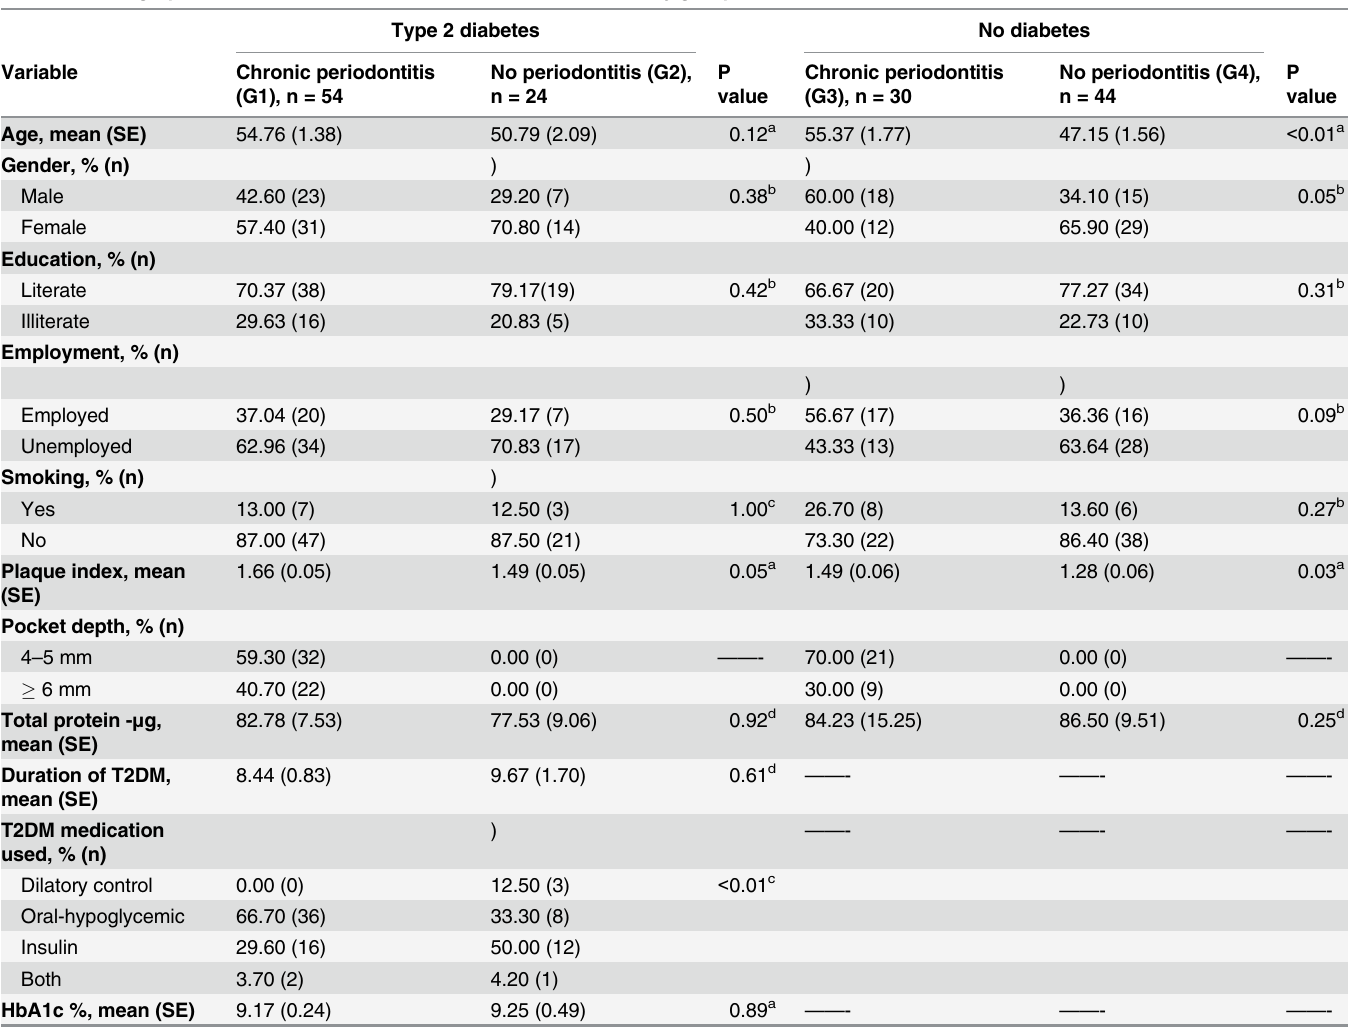
Table 1. Demographic characteristics and clinical indicators of the study